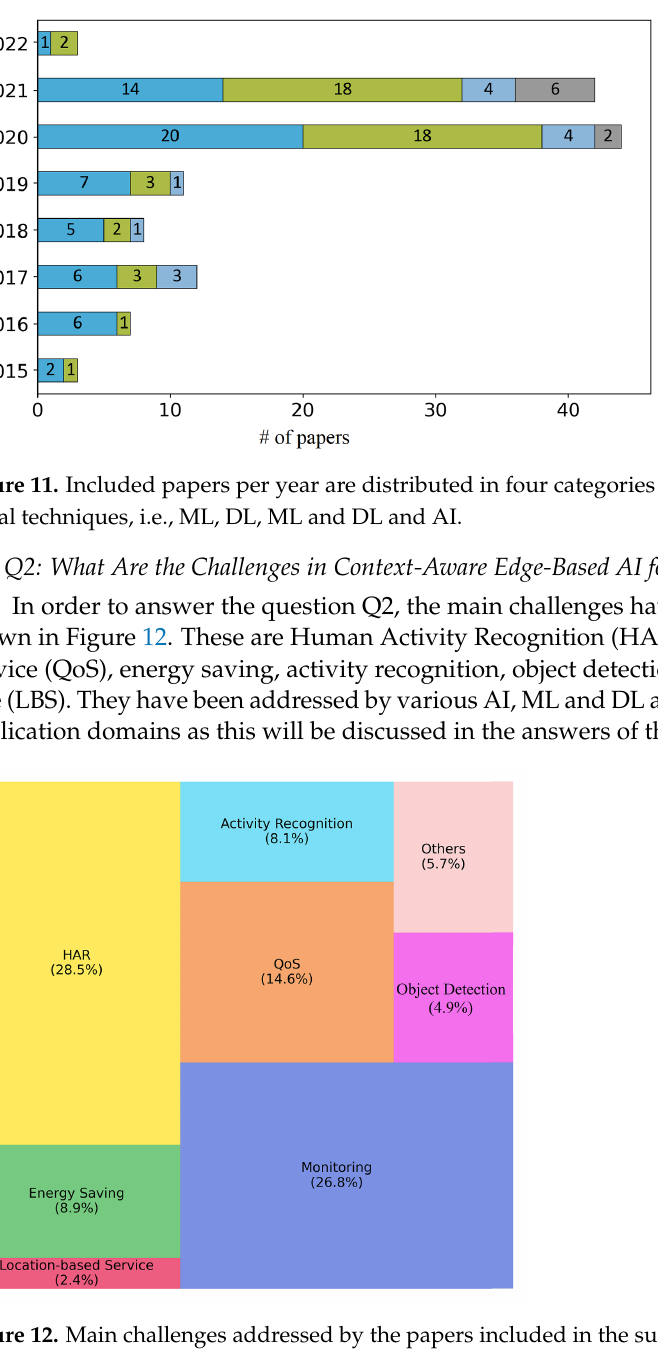
Figure 12. Main challenges addressed by the papers included in the